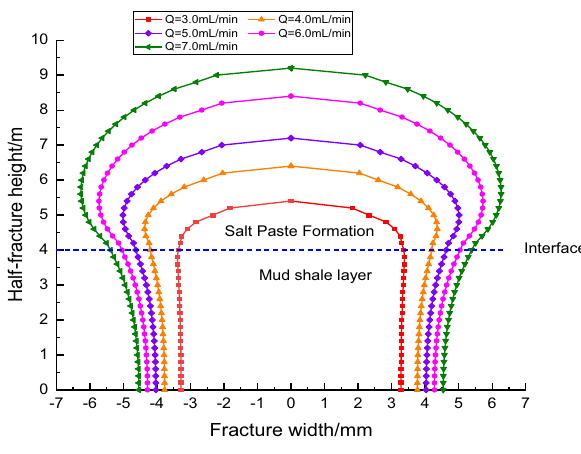
Fig. 21 Fracture morphology at different injection